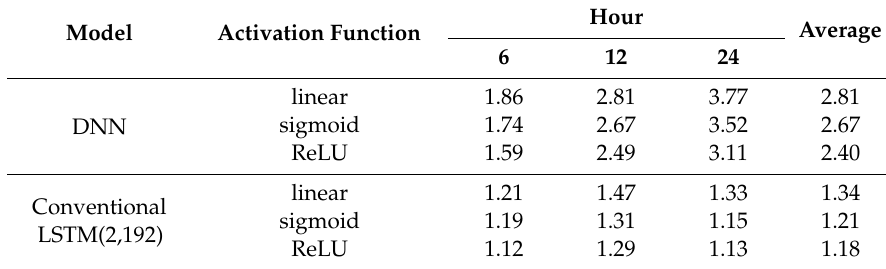
Table 3. Performance comparison of the root-mean-squared error (RMSE) according to di ff erent activation functions applied to the DNN and conventional